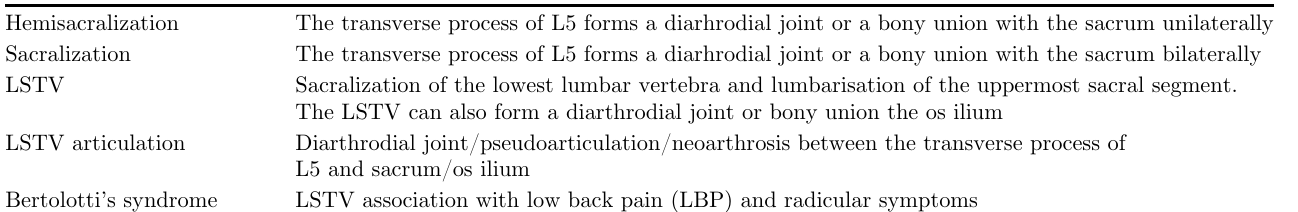
Table 1. De fi nitions.